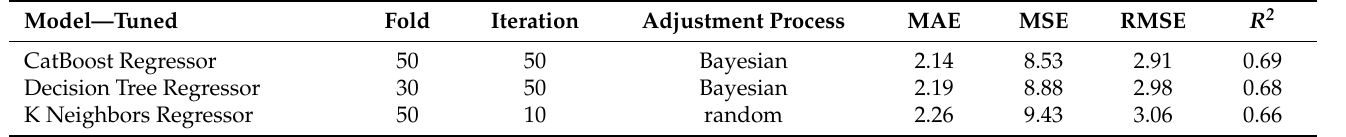
Table 5. Selection of the value “Iteration” to “Adjustment Process”, analyzing the determination coefficient and mean squared error